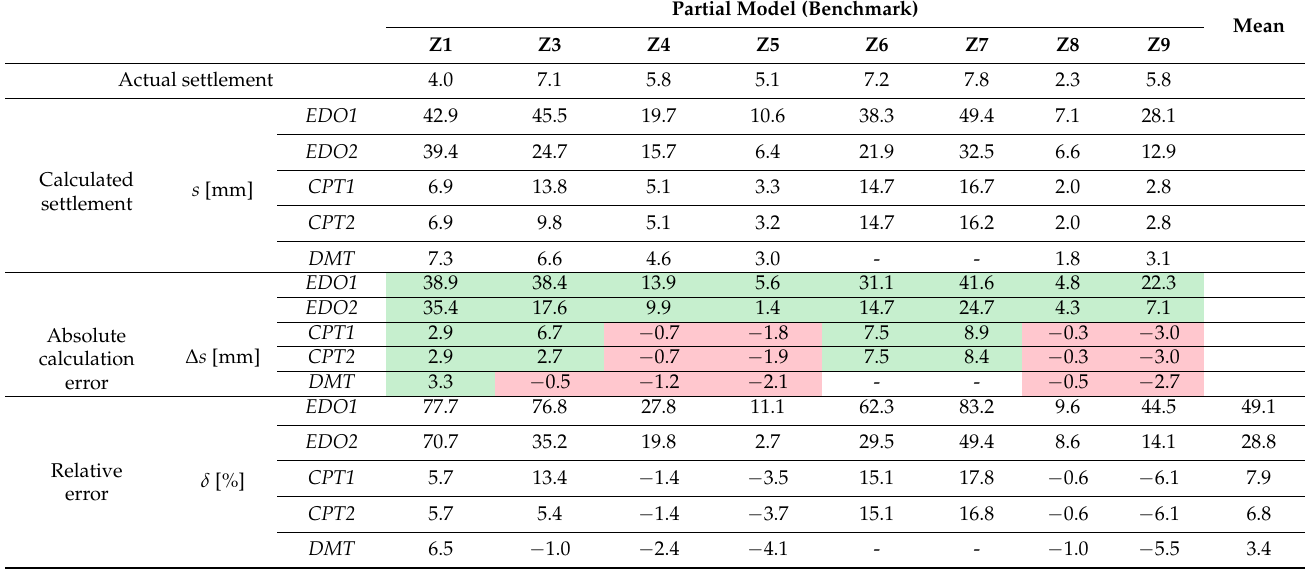
Table 5. A comparison of the final settlements and settlements calculated for partial